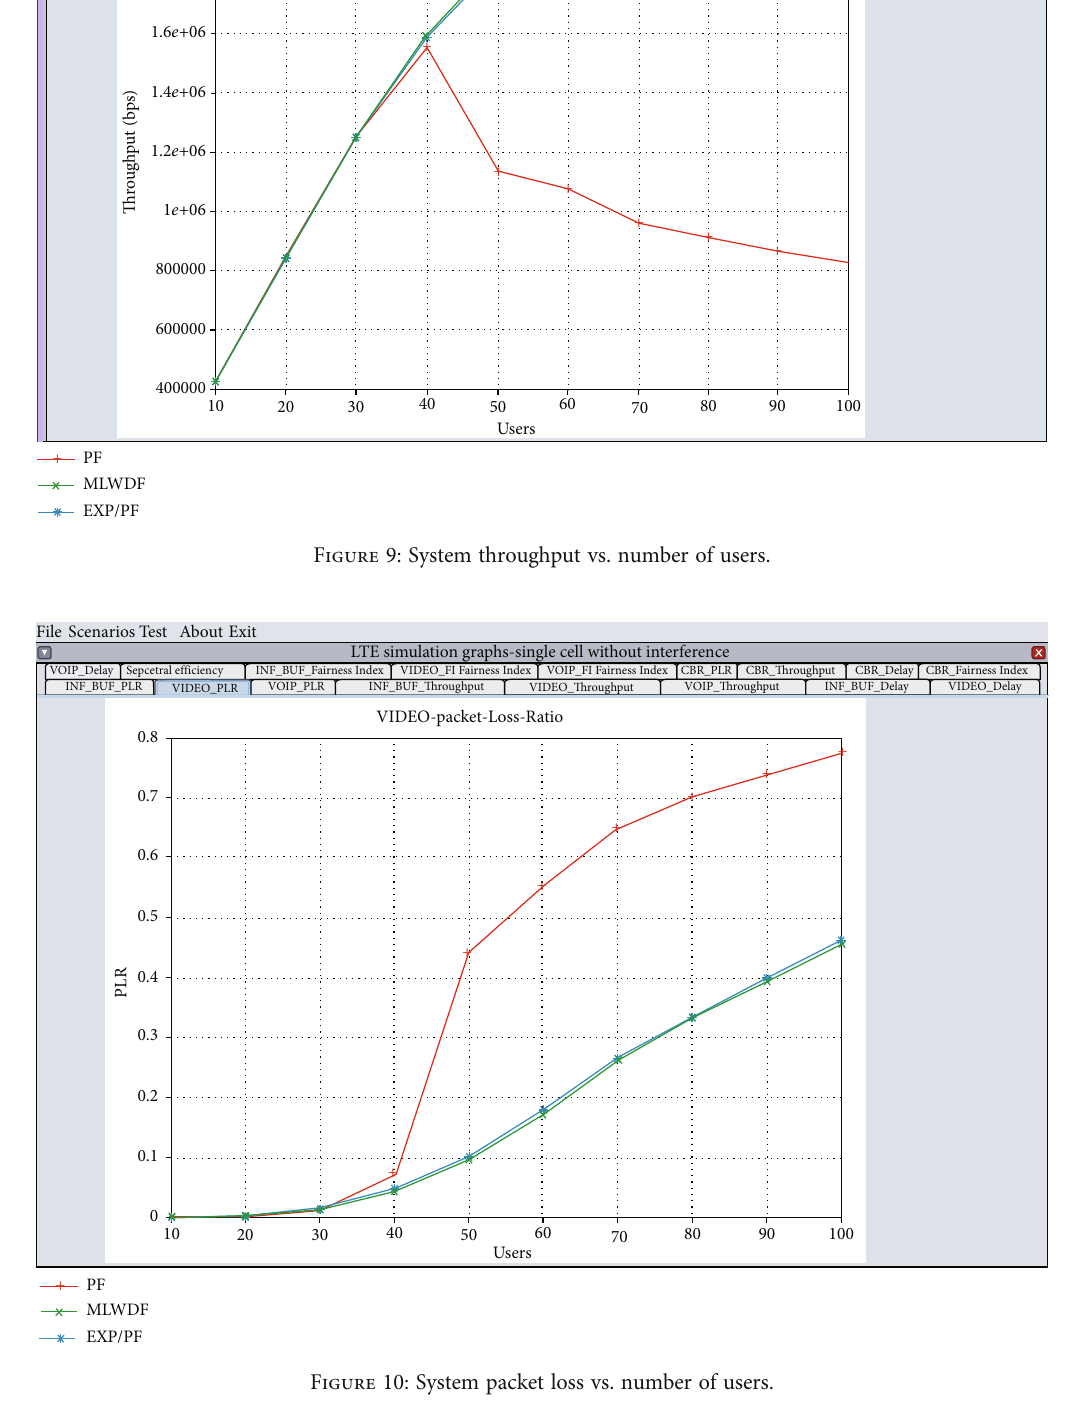
Figure 10: System packet loss vs. number of